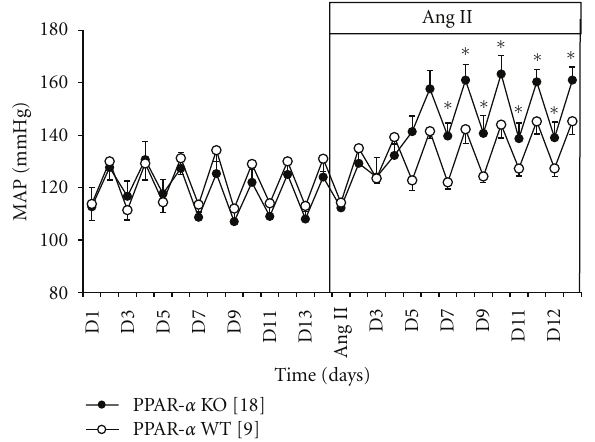
Figure 1: Mean arterial pressure of PPAR- α KO mice [18] ( • ) and PPAR- α WT mice [9] (o) during control days 1–13 and treatment of Ang II days 1–12. MAP was significantly higher in Ang II-treated PPAR- α KO versus Ang II-treated WT mice ( ∗ P < 0 . 05).